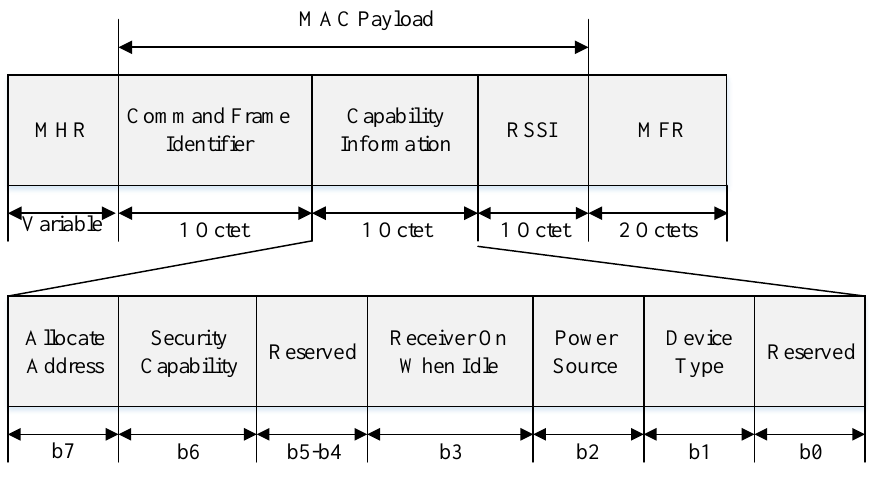
Figure 6. Format of the proposed association-request frame.